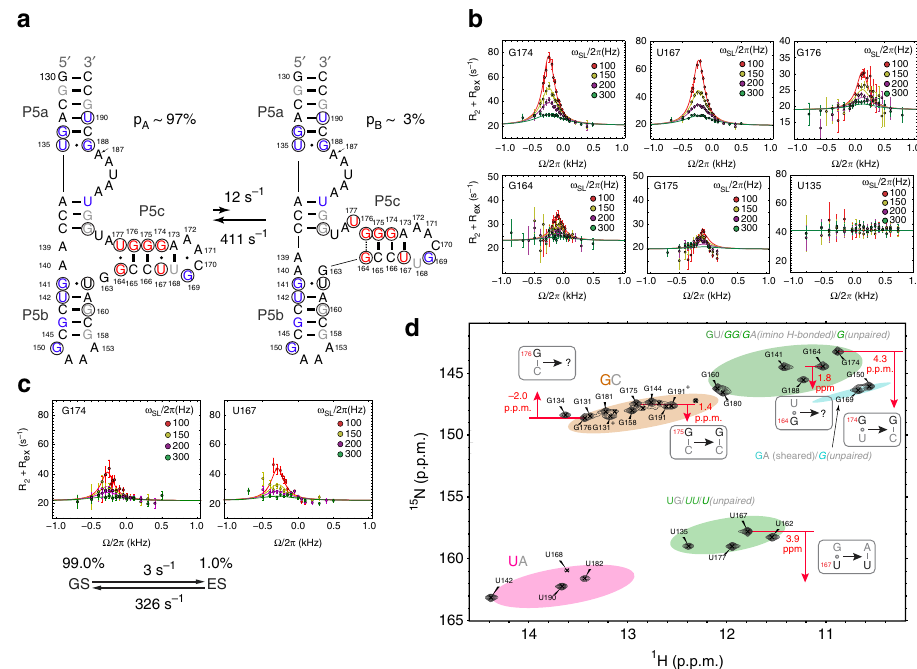
Figure 2 | RD analysis of excited state in tP5abc. ( a ) Chemical exchange with proposed excited state that features partially folded P5c. Exchange parameters are obtained from global fitting the RD profiles. Residues are coloured as follows: RD detected, red; no RD detected, blue; immeasurable due to severe overlap or weak intensity, grey; and all others, black. Residues with imino resonances that undergo changes or disappear on addition of Mg 2 þ are circled. ( b , c ) Off-resonance RD profiles in the absence ( b ) and presence ( c ) of 1mM Mg 2 þ . The complete data set is shown in Supplementary Fig. 3. The data in b and c are globally fitted using two-state exchange model and Laguerre equation 61 (see Supplementary Tables 2 and 3). ( d ) 2D 1 H- 15 N HSQC spectrum of 1mM WT tP5abc in 10mM sodium phosphate and 0.01mM EDTA, pH 6.4, at 10 (cid:2) C. The residues showing pronounced RD are highlighted by red arrows starting at 15 N chemical shift of GS and ending at 15 N chemical shift of ES, and are labelled with the associated Do . Also shown is the ellipsoid distribution of 15 N (N1/3) and 1 H (H1/3) chemical shifts of RNA imino groups in different base pair contexts. The chemical shift data are extracted from the BMRB database. The ellipses are centred on the average chemical shift and have size that corresponds to twice the s.d. in the